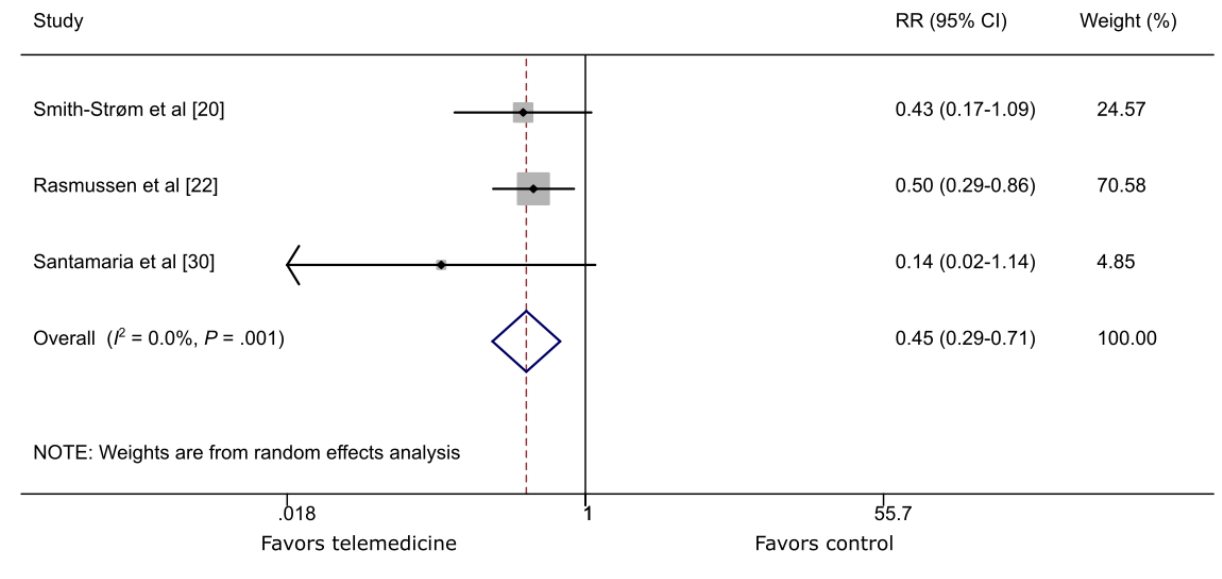
Figure 5. The effect of telemedicine on amputation. RR: risk